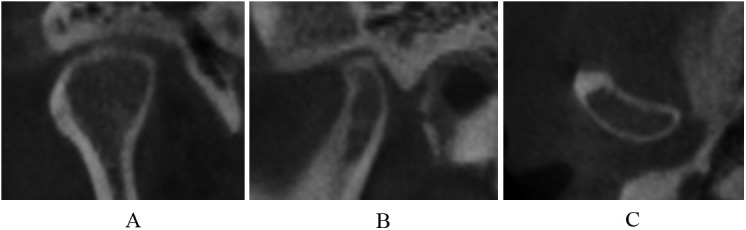
Subcortical sclerosis in coronal (A), sagittal (B), and axial (C) images.